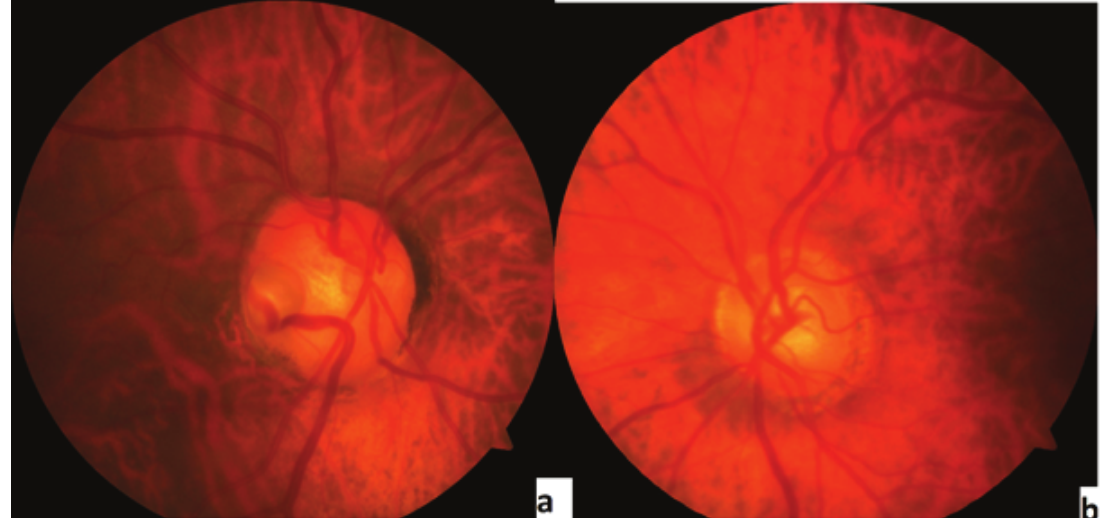
Figure 1. (a&b) Fundus photograph of the patient demonstrates a temporal pit of the optic nerve (PON) and a retinochoroidal vein that sinks into the PON in the right eye and a normal optic disc in the left eye.